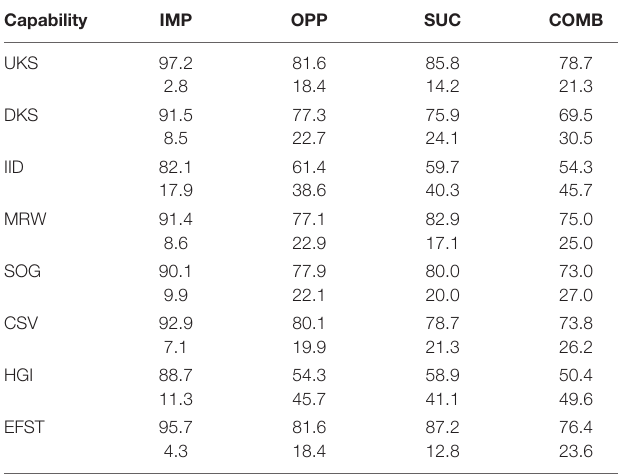
TABLE 1 | Frequencies and percentages of